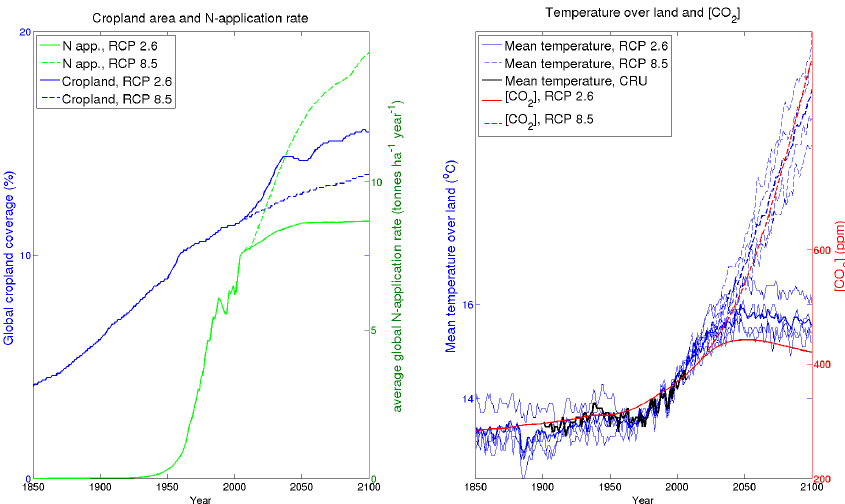
Figure A1. Input used for the simulations over the historic and scenario RCP2.6 and 85 periods: (a) global cropland cover (%) from Hurtt et al. (2011) with mean N-fertiliser application rate (Stocker et al., 2013; Zaehle et al., 2010a); (b) [CO 2 ] and mean terrestrial temperature from the four GCMs (Sect. 2.2).